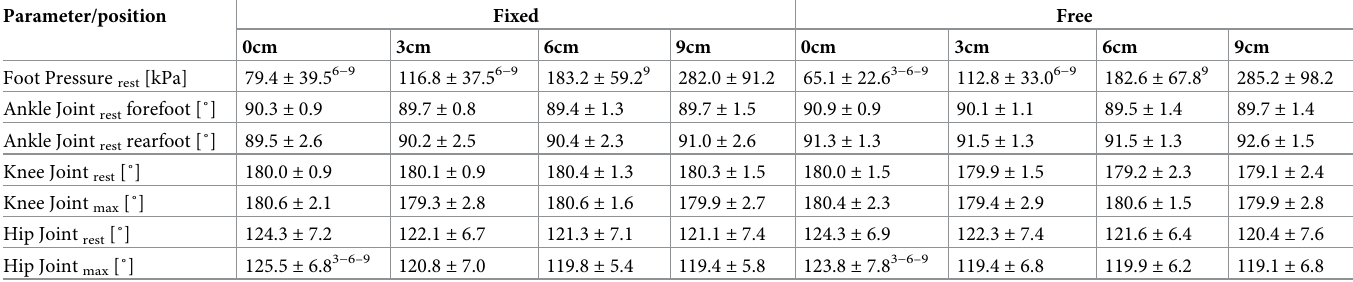
Table 1. Average (mean ± SD) values of the foot pressure at rest, forefoot and rearfoot ankle joint angle at rest, knee joint angle at rest and maximum, hip joint angle at rest and maximum, at the four positions (0–9 cm) and two conditions (fixed, free).